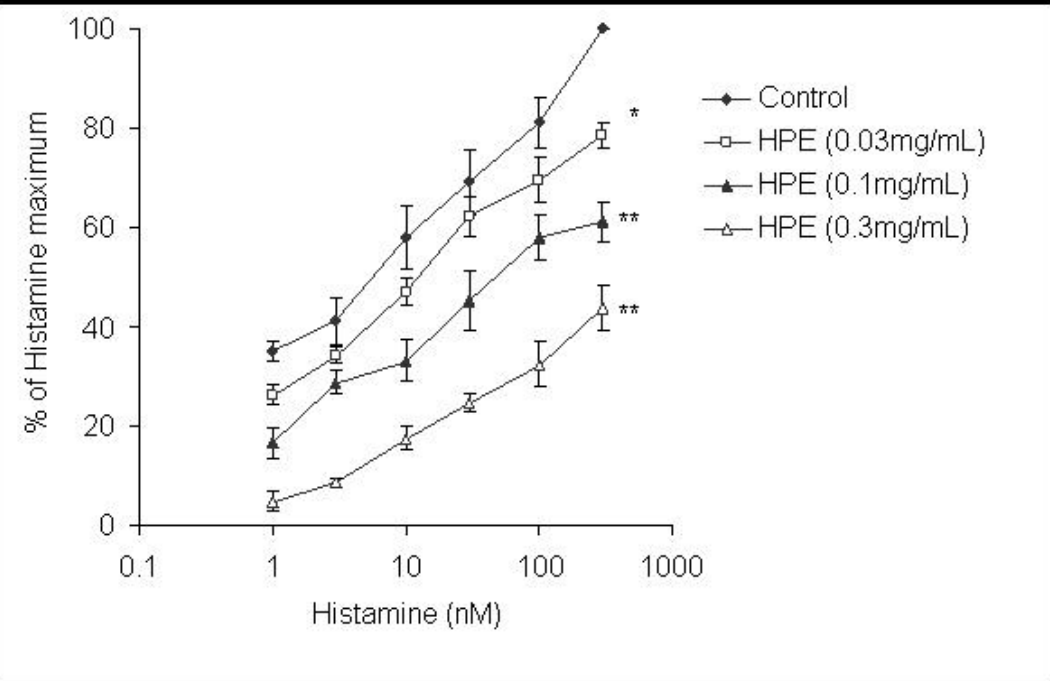
Figure 4. Comparison of dose-response curves of histamine in absence and presence of Helichrysum plicatum extract (HPE) in isolated rat ileum.